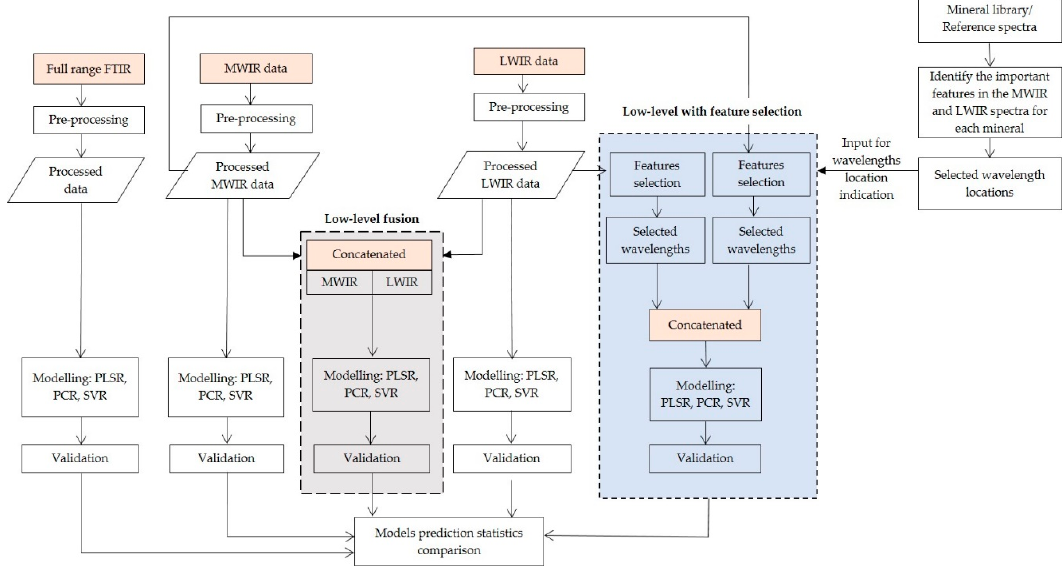
Figure 2. Workflow diagram depicting the steps of the low-level fusion (1) without feature selection (the grey box) and (2) with feature selection (the blue box).